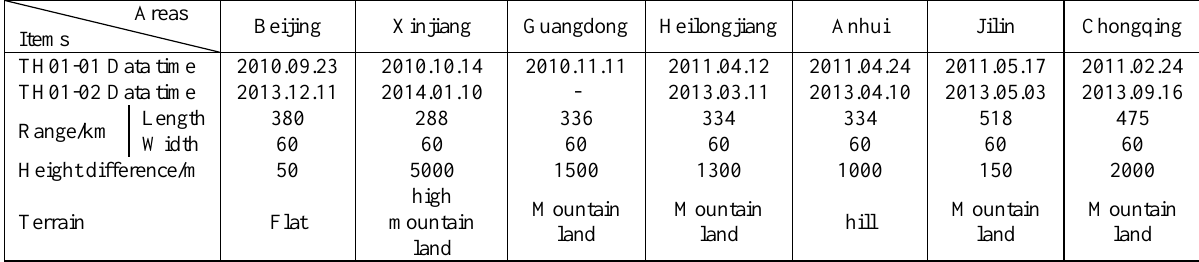
Table 1. Terrain and image data of calibration fields （ Data time original:Year/month/day ） distributed. The number of ground control points is shown in